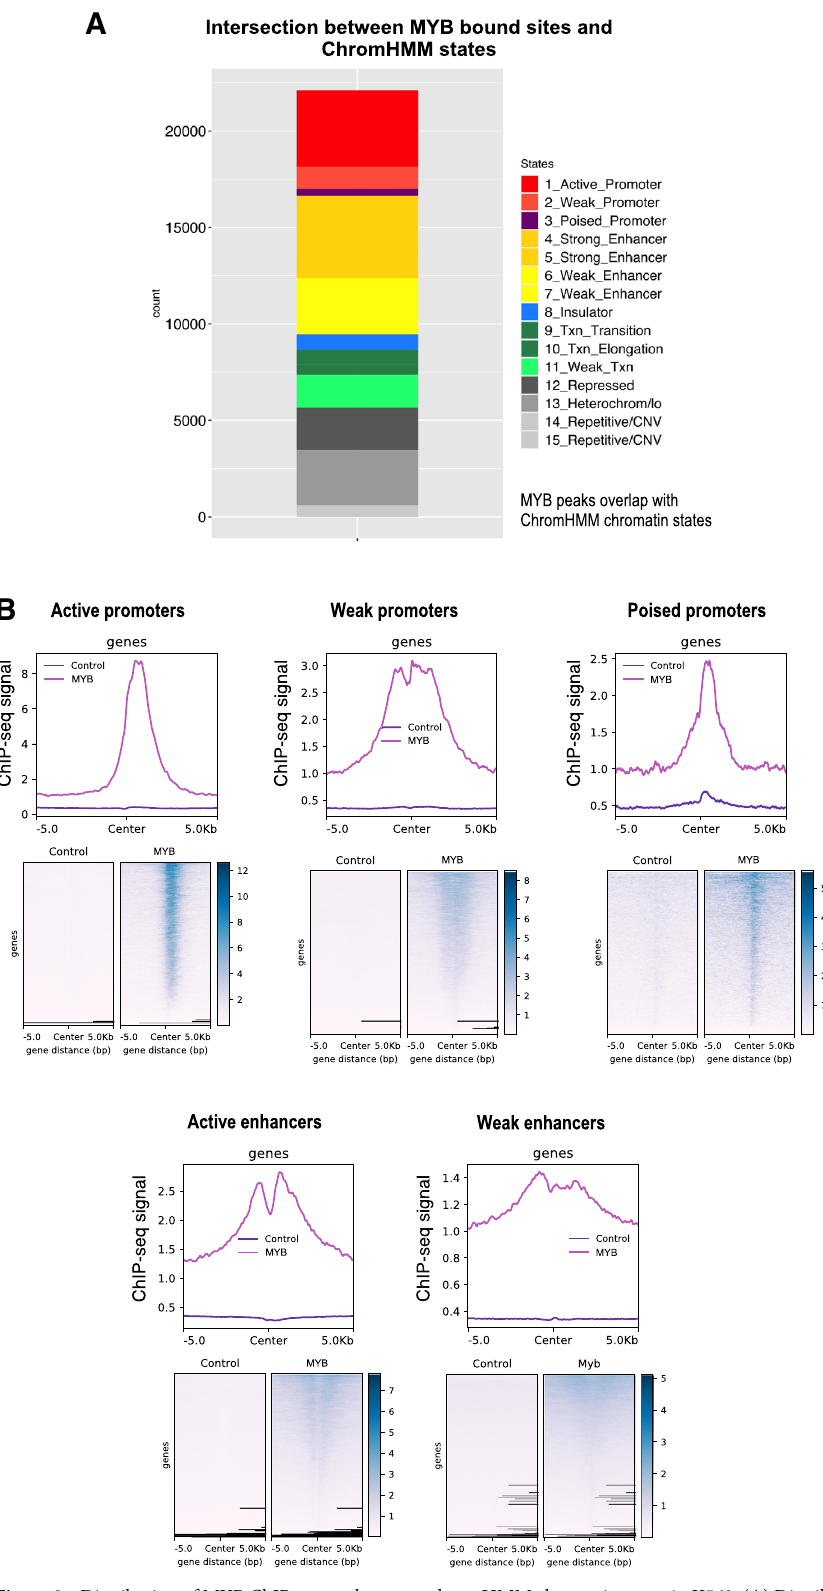
Figure 2. Distribution of MYB ChIP-seq peaks across chromHMM chromatin states in K562. ( A ) Distribution of overlaps between MYB ChIP-seq peaks and chromHMM chromatin states from K562 cells (UCSC Accession: wgEncodeEH000790), the stacked barplot was generated using the R environment v3.6.1 and ggplot2 package v3.3.2. To investigate overlap between the current MYB ChIP-seq peaks and chromHMM chromatin states from K562, we used bedtools v2.17.0 74 . ( B ) Heatmaps and line plots showing MYB ChIP-seq aggregated signals aligned at and ± 5 kb around the center of different chromatin state intervals from K562 chromHMM segmentations. Heatmaps and line plots were made using deepTools2 v3.3.0 77